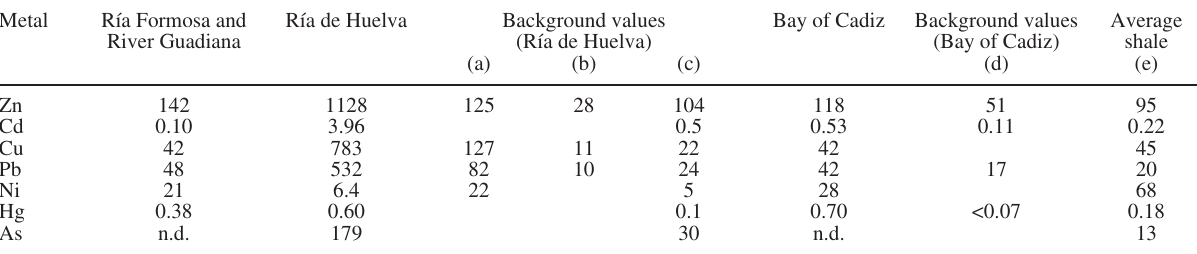
Table 3. – Average concentration in sediment from the three coastal zones and background values for the Ría de Huelva, Bay of Cadiz and average shale composition. The results are expressed as µg·g -1 dry weight. Metal Ría Formosa and Ría de